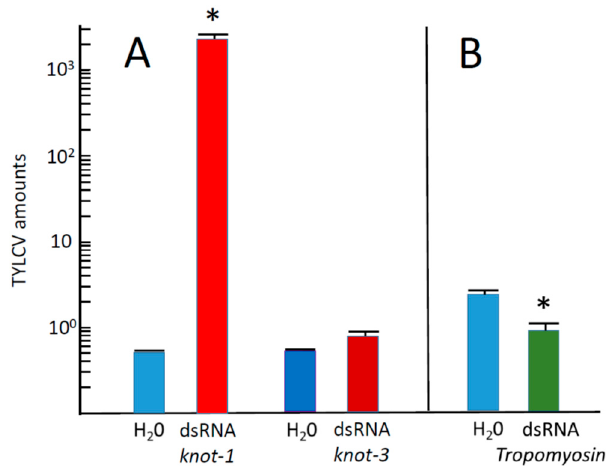
Figure 6. TYLCV amounts acquired by whiteflies with down ‐ regulated knot ‐ 1 and knot ‐ 3 during a 48 h acquisition period on infected tomato leaves. ( A ) Viral amounts (viral genomes per insect β ‐ actin genes) in whiteflies caged with down ‐ regulated knot ‐ 1 (dsRNA knot ‐ 1 ) or knot ‐ 3 (dsRNA knot ‐ 3 ) compared with control not ‐ silenced insects (H 2 O); ( B ) viral amounts in whiteflies caged with down ‐ regulated tropomyosin (dsRNA tropomyosin ) compared with control insects (H 2 O) ( n = 3; mean ± SEM). An asterisk above the bars indicates significant differences between treatments at p < 0.05.